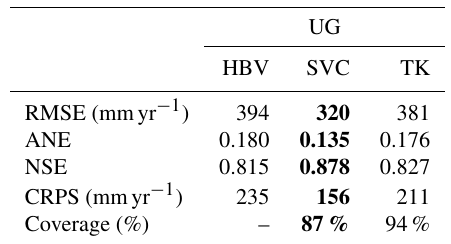
Figure A2. Scatter plot showing the predicted mean annual runoff (posterior mean of Q( A ) ) for SVC and the observed streamflow from fully gauged and partially gauged catchments when short records are omitted from the likelihood.